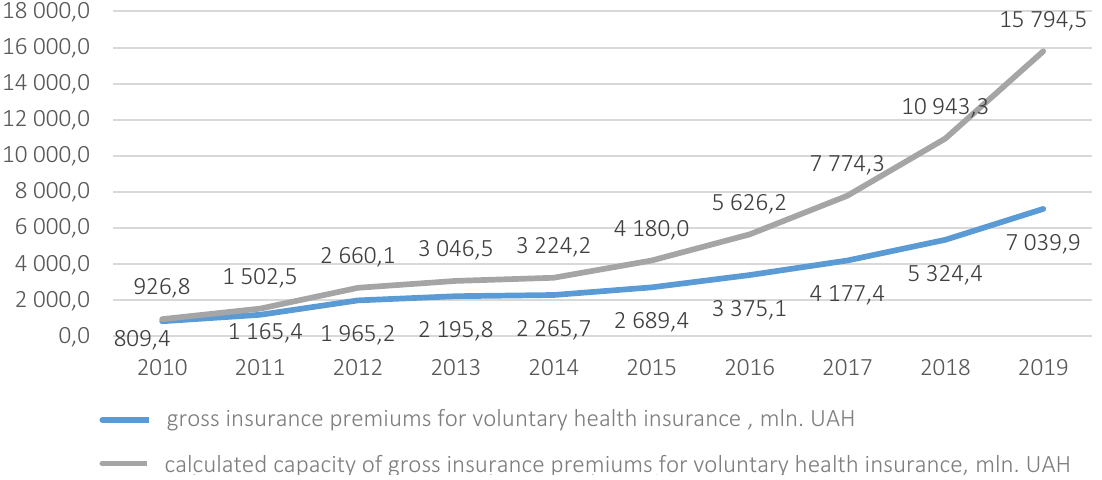
Figure 15. Real values of gross insurance premiums for voluntary health insurance in Ukraine and the values of this segment’s capacity in the period 2010–2019